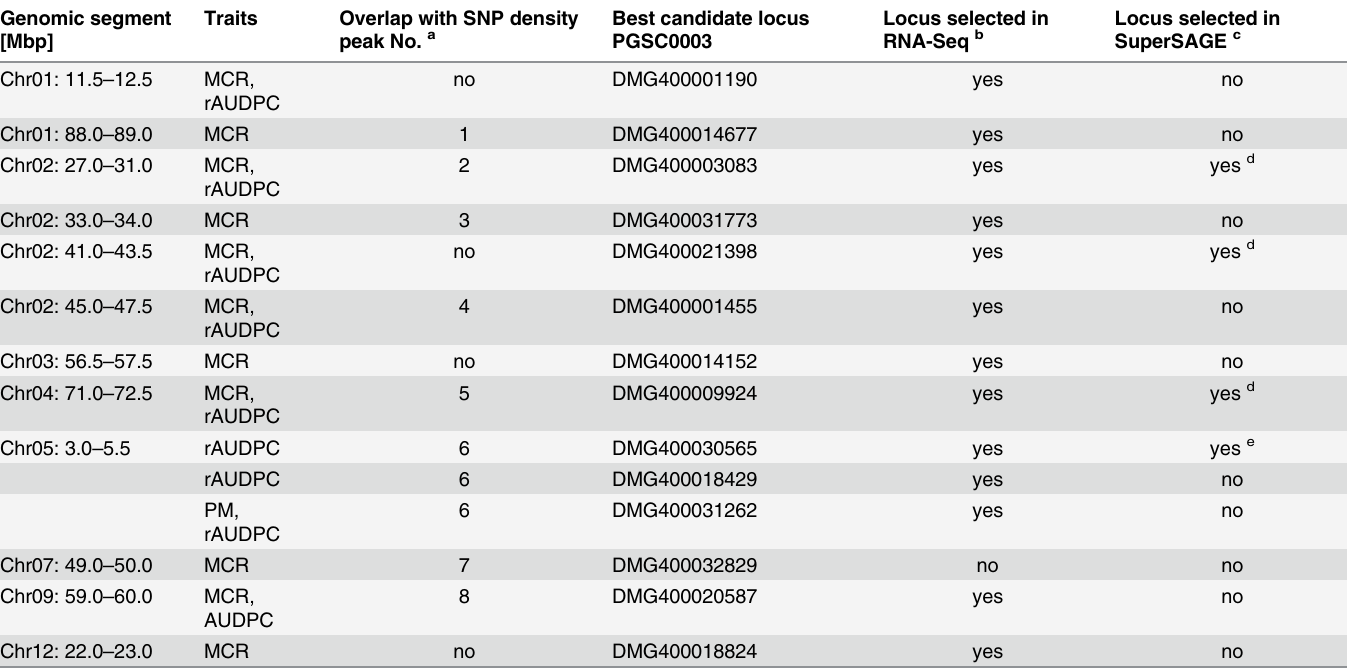
Locus selected in RNA-Seq